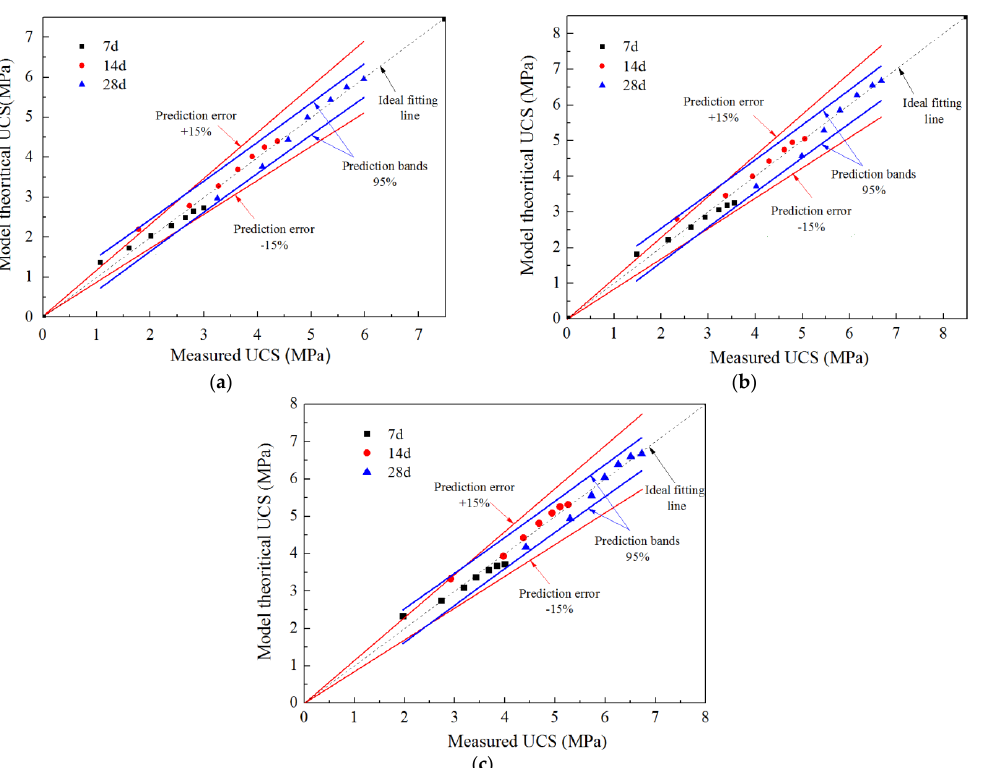
Figure 7. Relationship between the model theoretical UCS and measured UCS: ( a ) 7 d; ( b ) 14 d; ( c ) 28 d. According to the above analysis, also the histogram of UCS measured /UCS predicted based the median are all close to 1, which indicates that the predicted UCS of CPB is consistent with the experiment UCS. On the other hand, the skewness of the dataset under different curing ages are 0.0545, 0.0513 and 0.0958, respectively, it means that the frequency distribu- tion of the UCS measured /UCS predicted is positive partial, so the established mathematical strength model shows a slightly lower UCS than the experimental UCS under different curing ages, but this is good for the safety of the CPB when designing the mixture ratio of CPB.